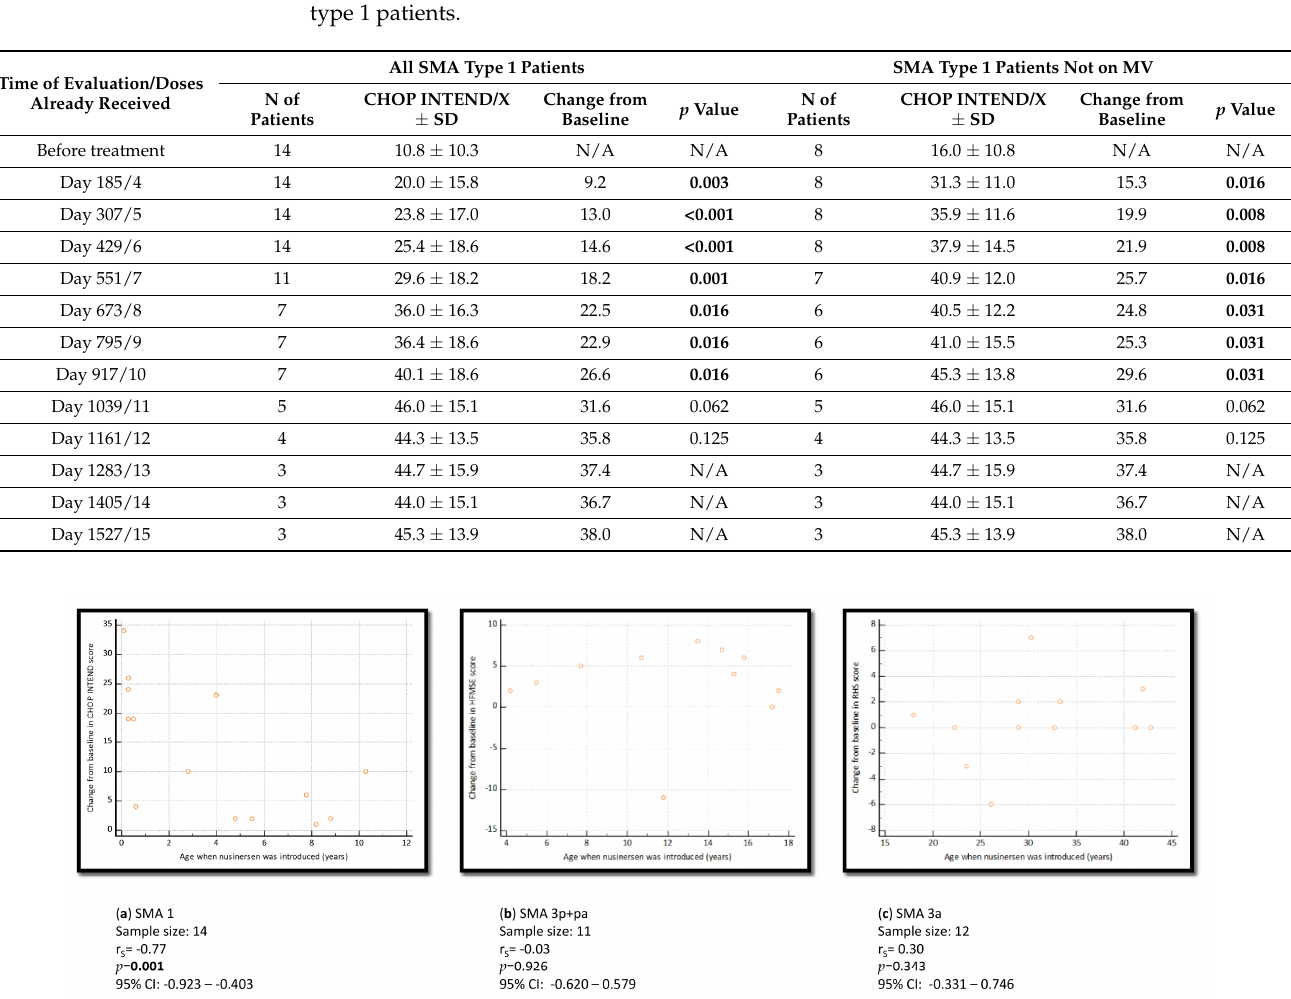
Figure 1. ( a – c ): The association between the change from baseline in motor function (after 5 doses of nusinersen) and the age at treatment initiation. ( a ) SMA type 1 patients; ( b ) SMA type 3p+pa patients; ( c ) SMA type 3a patients. Table 3. The average CHOP INTEND scores by the time points of the nusinersen injection in SMA type 1 patients.